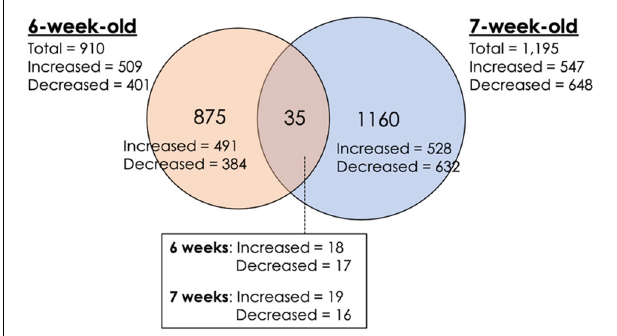
FIGURE 1 | Differential expression of transcripts associated with wooden breast (WB) myopathy in 6-week-old and 7-week-old broilers. Venn diagram depicts number of differentially expressed transcripts obtained from microarray study. Increased expression indicates the greater transcript abundance of the particular genes in WB sample relative to that of non-WB within the same slaughter age, vice versa for decreased expression. The criteria used in identification of differentially expressed transcripts are a combination between false discovery rate ≤ 0.05 and absolute fold change (|FC|) ≥